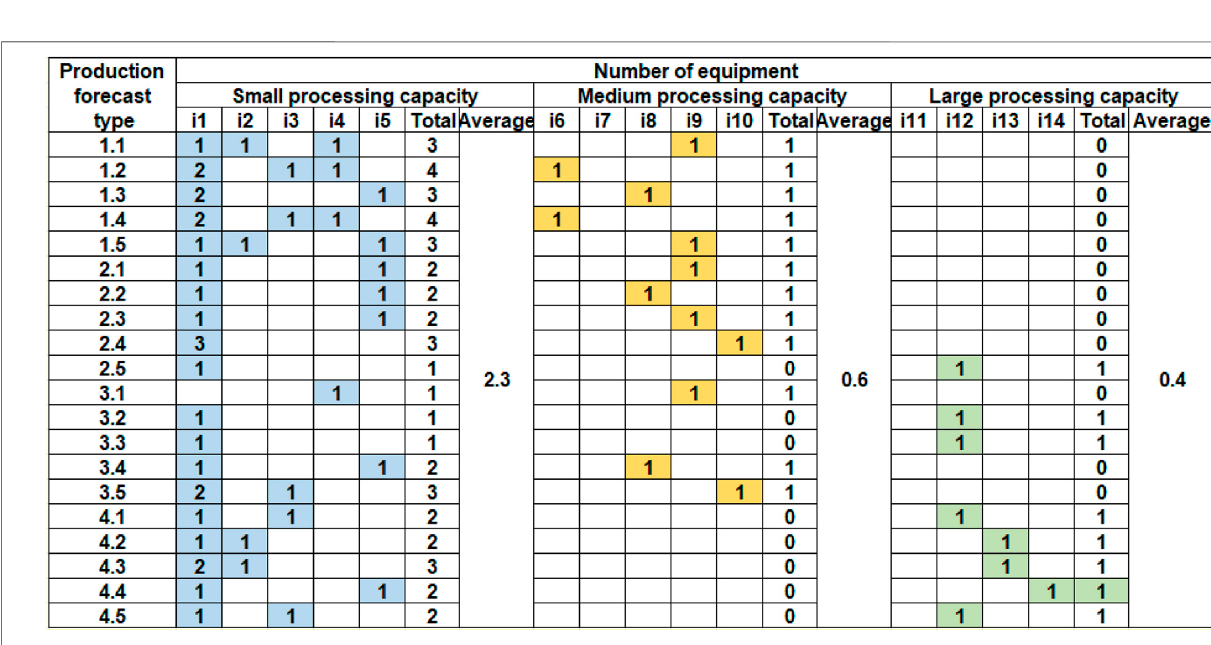
Frontiers in Energy Research |